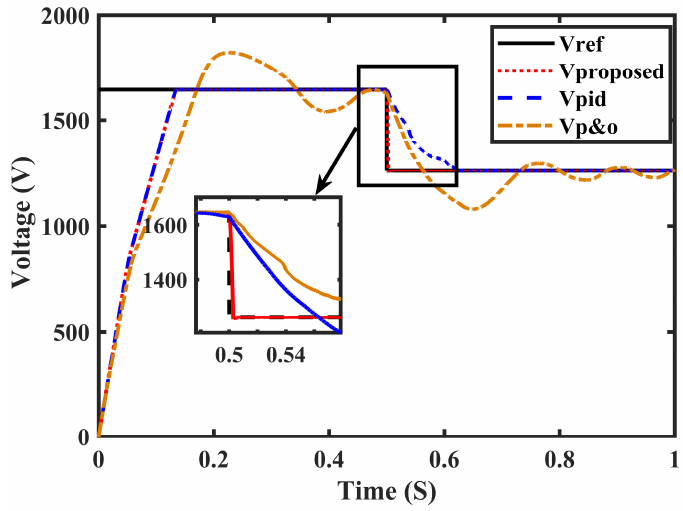
Figure 13. Voltage tracking without uncertainties.